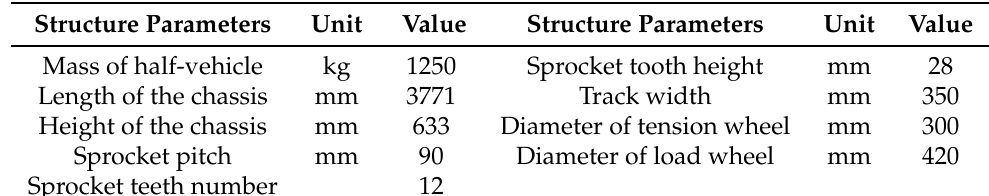
Figure 10. Hydraulic system model of the hydropneumatic suspension. Table 4. Vehicle parameters.